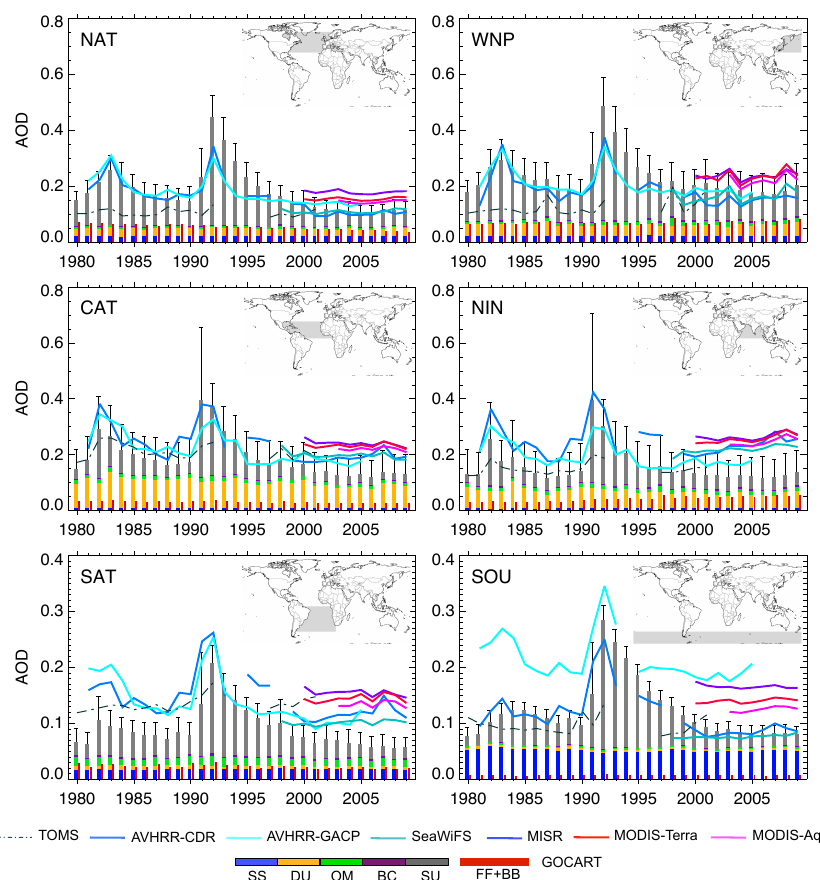
Fig. 9. Same as Fig. 6a but for six ocean regions of NAT, CAT, SAT, WNP, NIN, and SOU (domains shaded in grey). AVHRR retrievals are available over